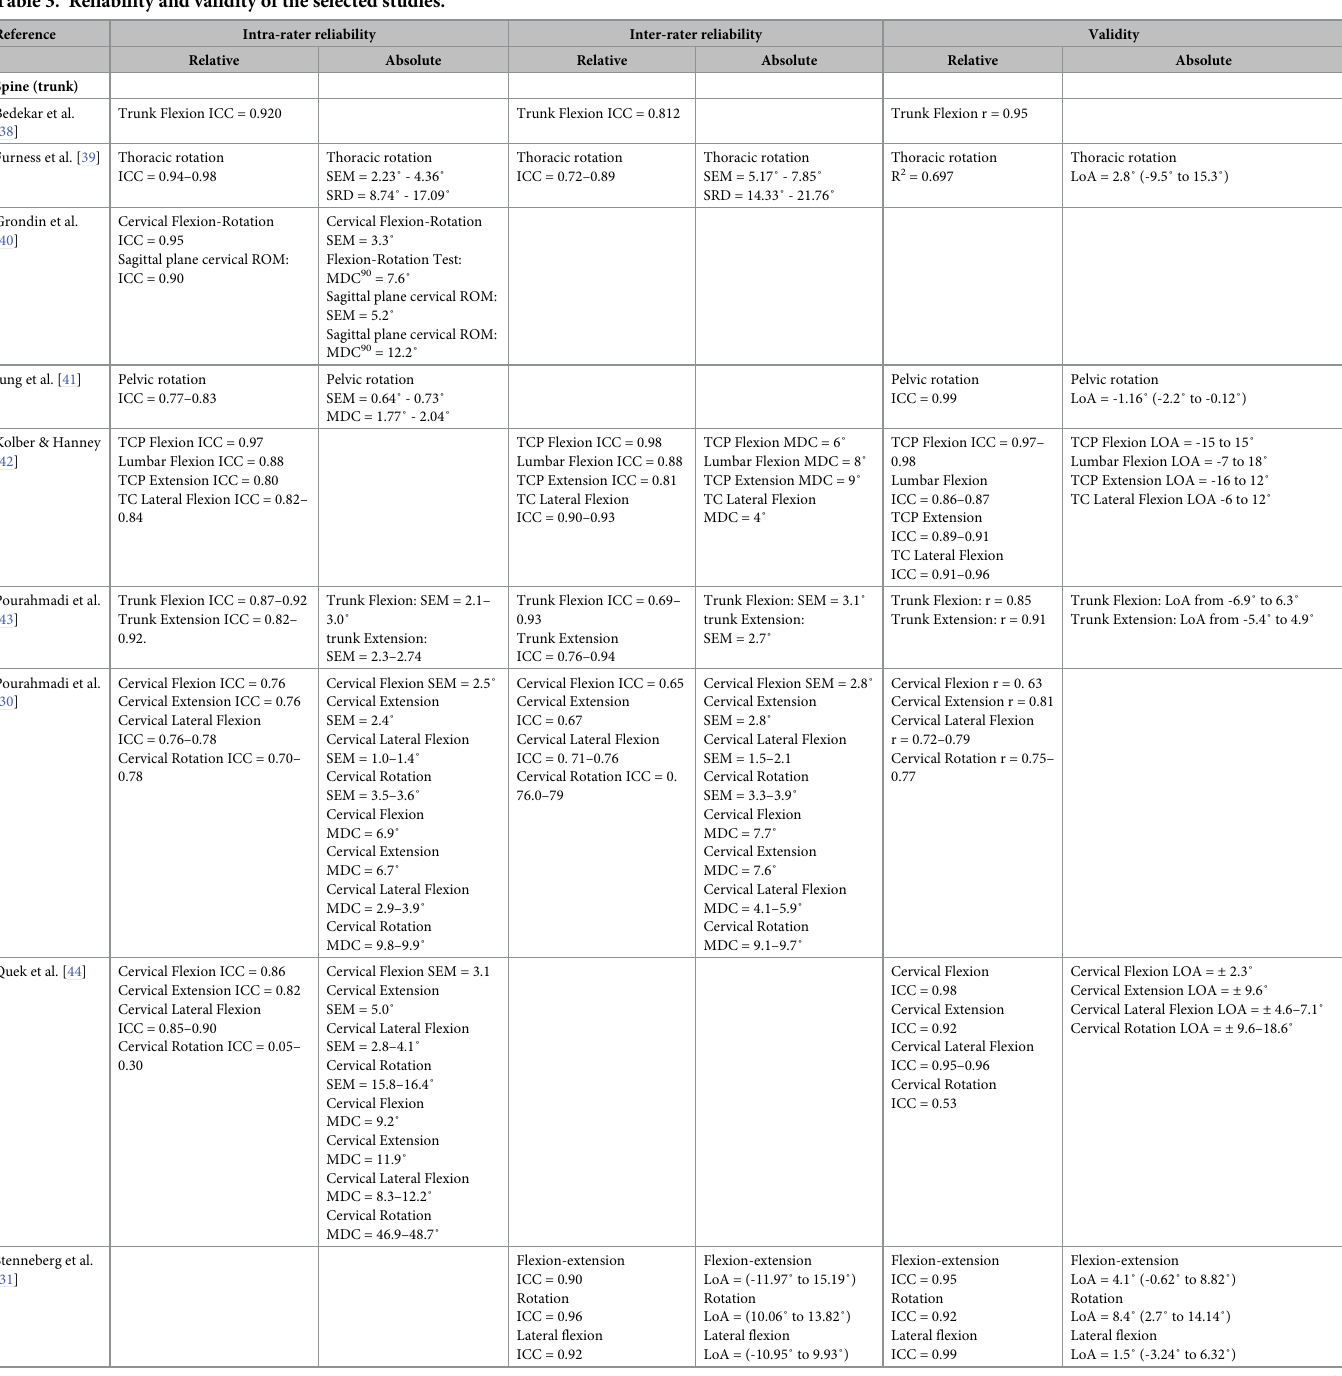
Table 3. Reliability and validity of the selected